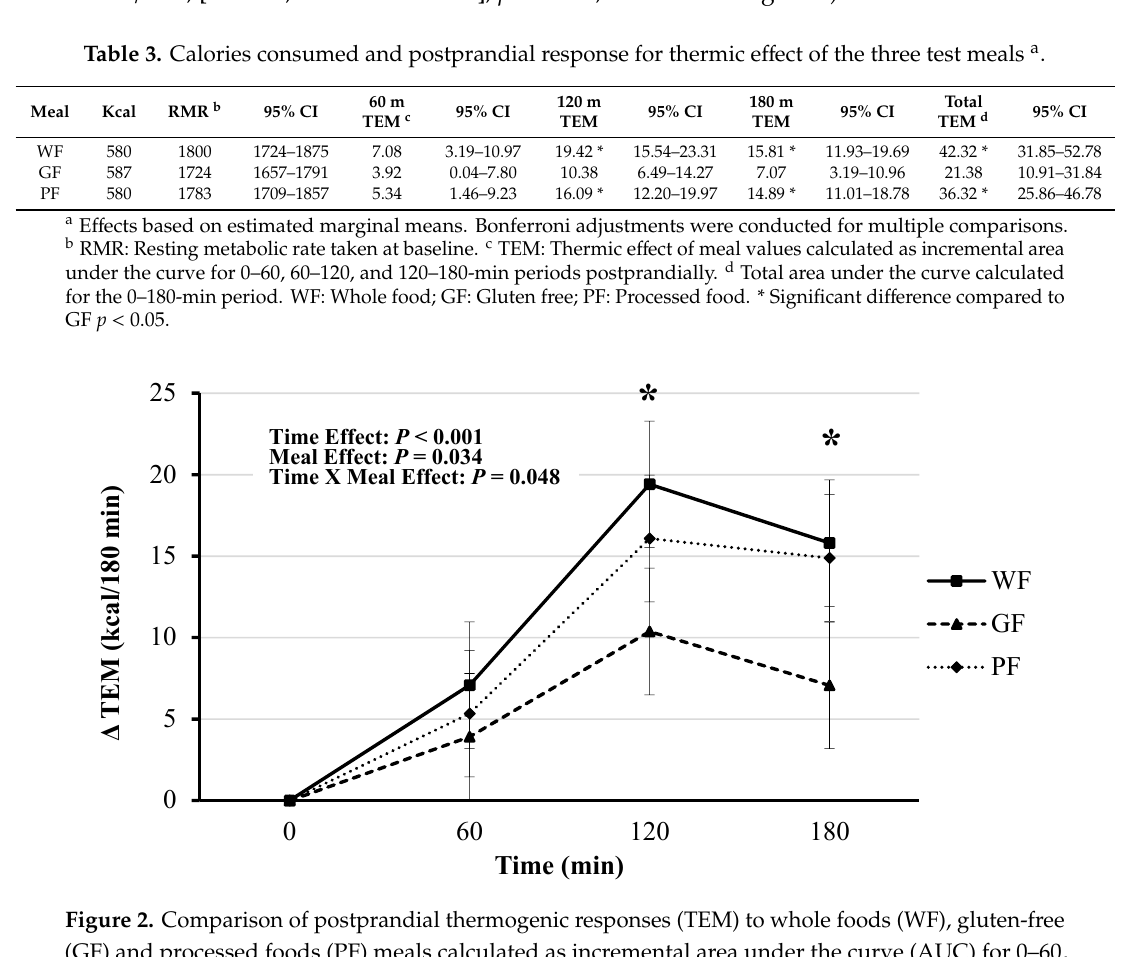
Figure 3. Comparison of total thermic effect of meal (TEM) area under the curve (AUC) for the 180– minute postprandial period following after consumption of whole foods (WF), gluten-free (GF) and processed (PF) meals. * Significant difference compared to GF p < 0.05. Data displayed as means ±95% confidence intervals. 4.3. Respiratory Exchange Ratio (RER) and Substrate Utilization